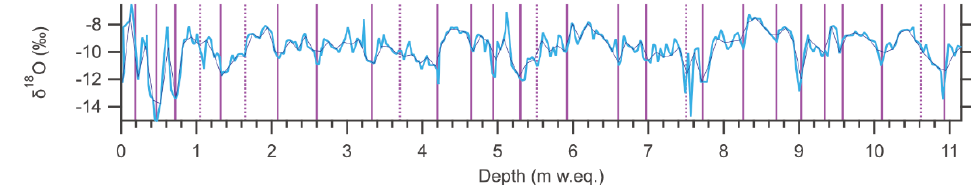
Figure 7. Dating approach A based on the discrete 5 cm δ 18 O record (light blue line) of the Young Island ice core and its 3 point running average (thin dark blue line) using local troughs as winter markers (vertical purple lines); questionable years are marked as dashed lined.